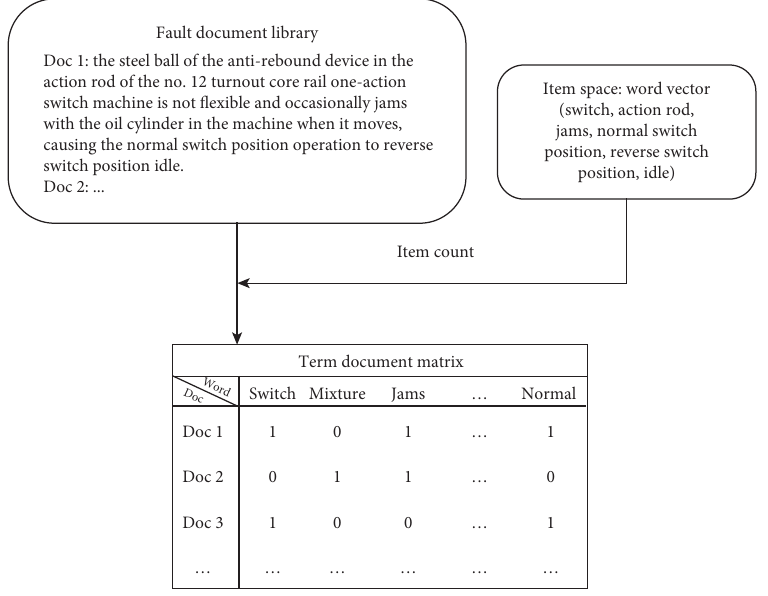
Figure 7: Expression process of fault document in term space.